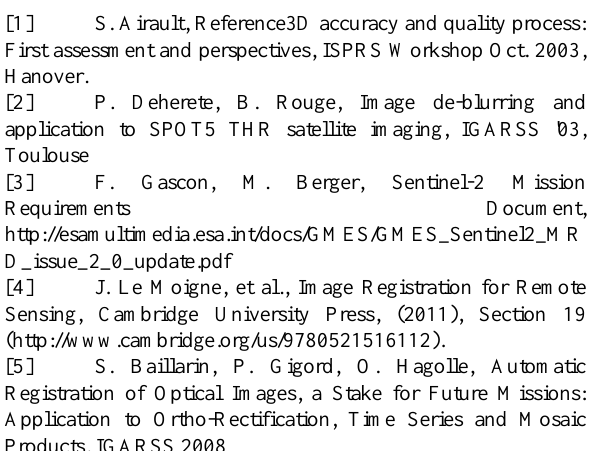
Figure 9: Radiometric corrections - B2 band before and after de-noising